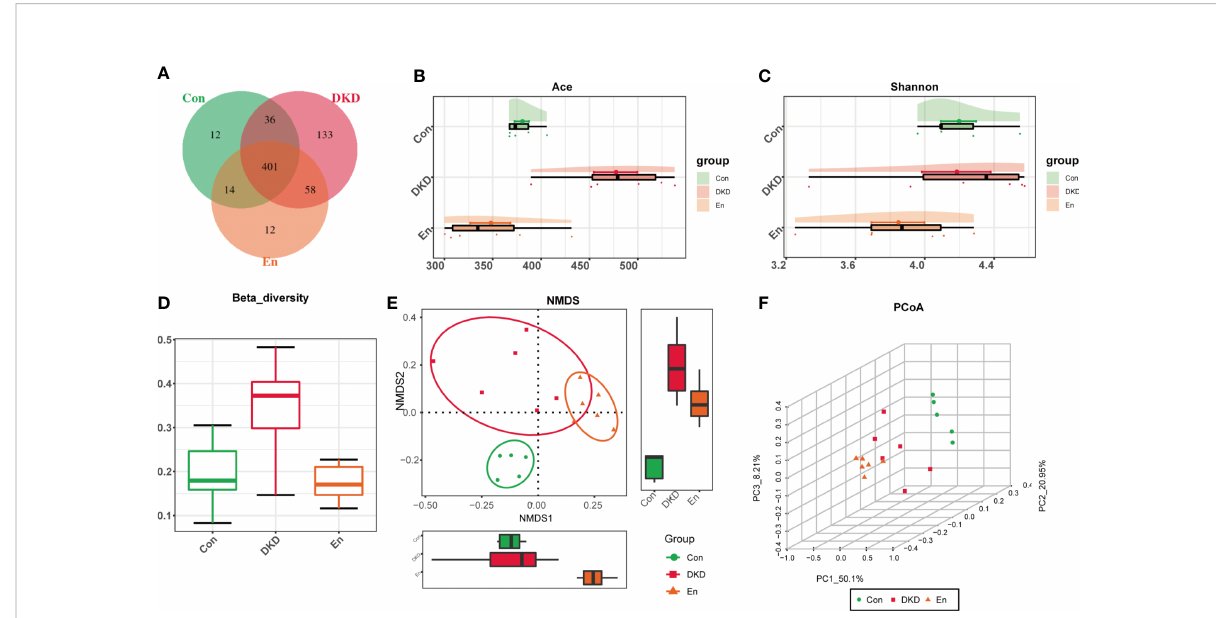
FIGURE 2 Features of gut microbiota. (A) Venn diagram of OTU distribution. (B) Ace index: estimate the number of OTUs in fecal samples. (C) Cloud plot of Shannon index. (D) Box diagram of b diversity based on weighted-Unifrac distance. (E) NMDS analysis based on Bray-Curtis algorithm. (F) 3D plot of PCoA analysis based on weighted-UniFrac distance. PC1, PC2 and PC3 represent the fi rst principal coordinate, the second principal coordinate and the third principal coordinate,